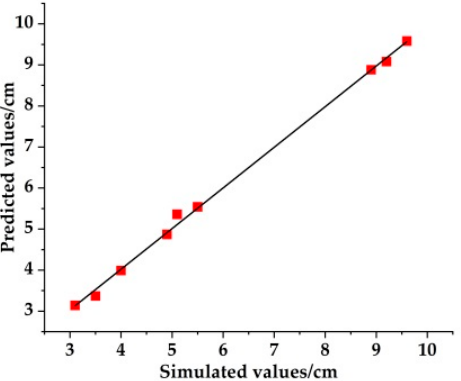
Figure 14. Correlation between the predicted values and the simulated values.